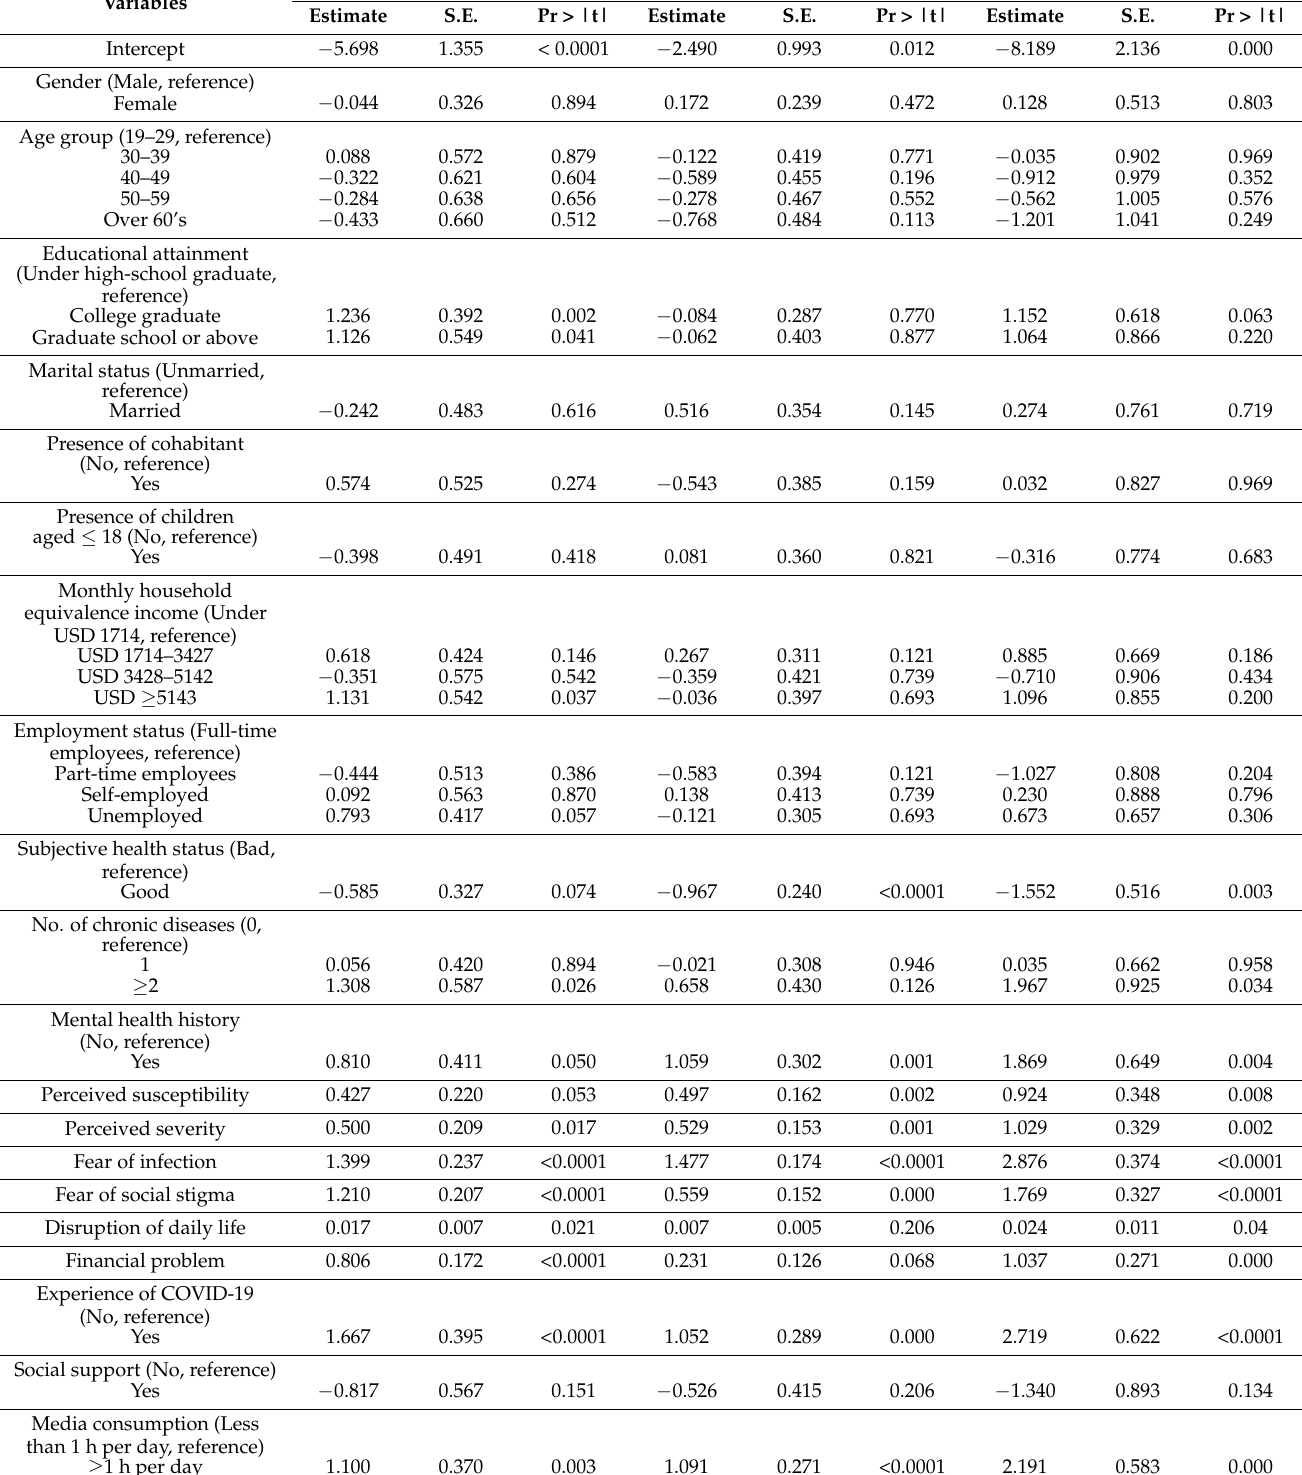
Table 4. Results of multivariate regression analysis ( n =